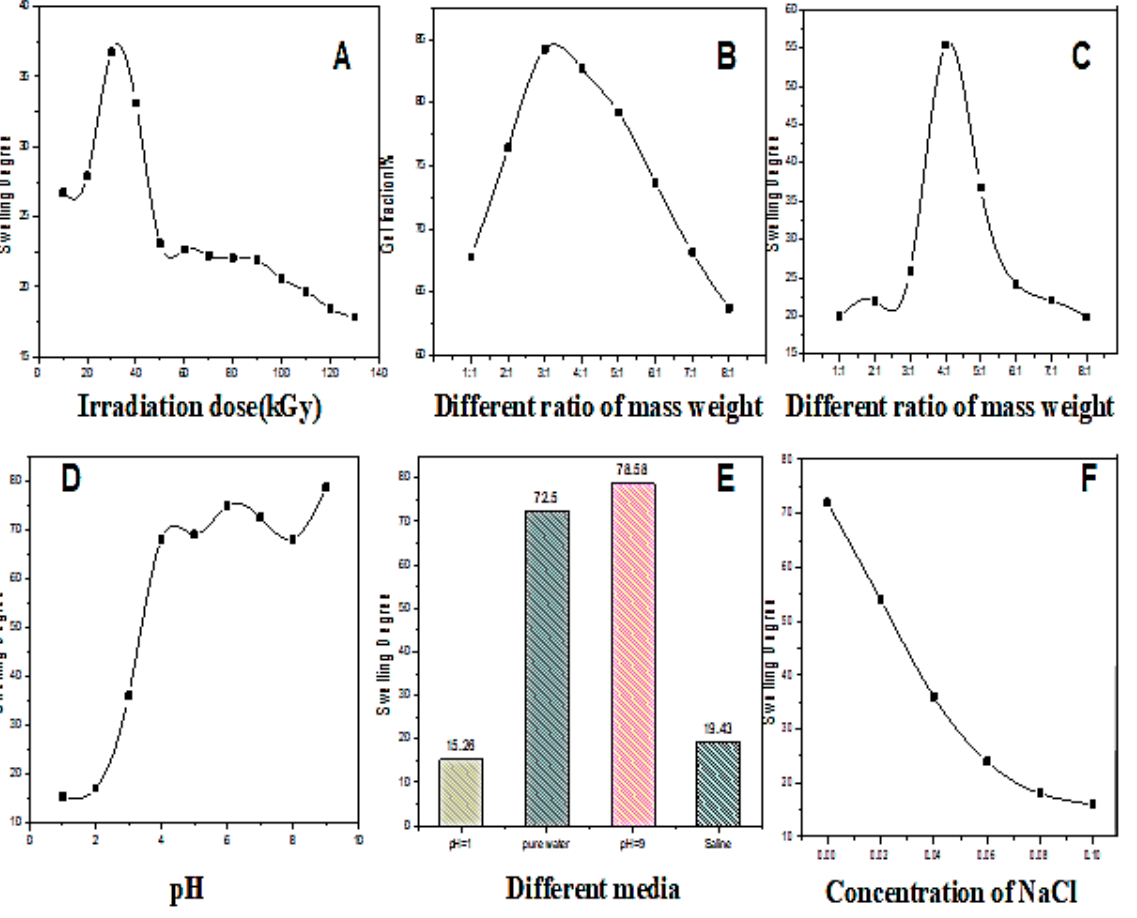
Figure 1. Swelling behavior of CMCS/PVA hydrogel under different conditions. ( A ) Swelling degree curves with varying irradiation doses; ( B ) gel fraction curves with varying ratios of mass weight; ( C ) swelling degree curves with varying ratios of mass weight; ( D ) swelling degree curves with varying pH values; ( E ) swelling degree curves in different media; ( F ) swelling degree curves with varying concentrations of NaCl solution. T = 298 K; irradiation dose = 30